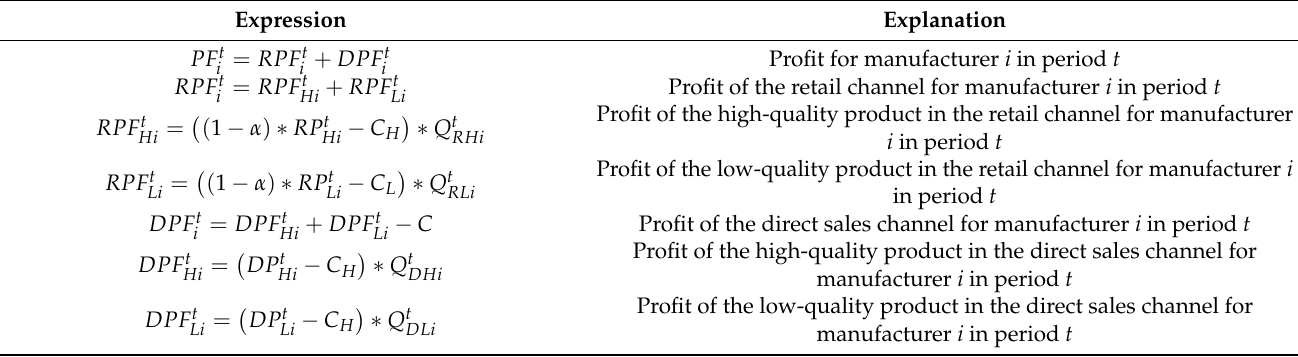
Table 1. Profit expressions.